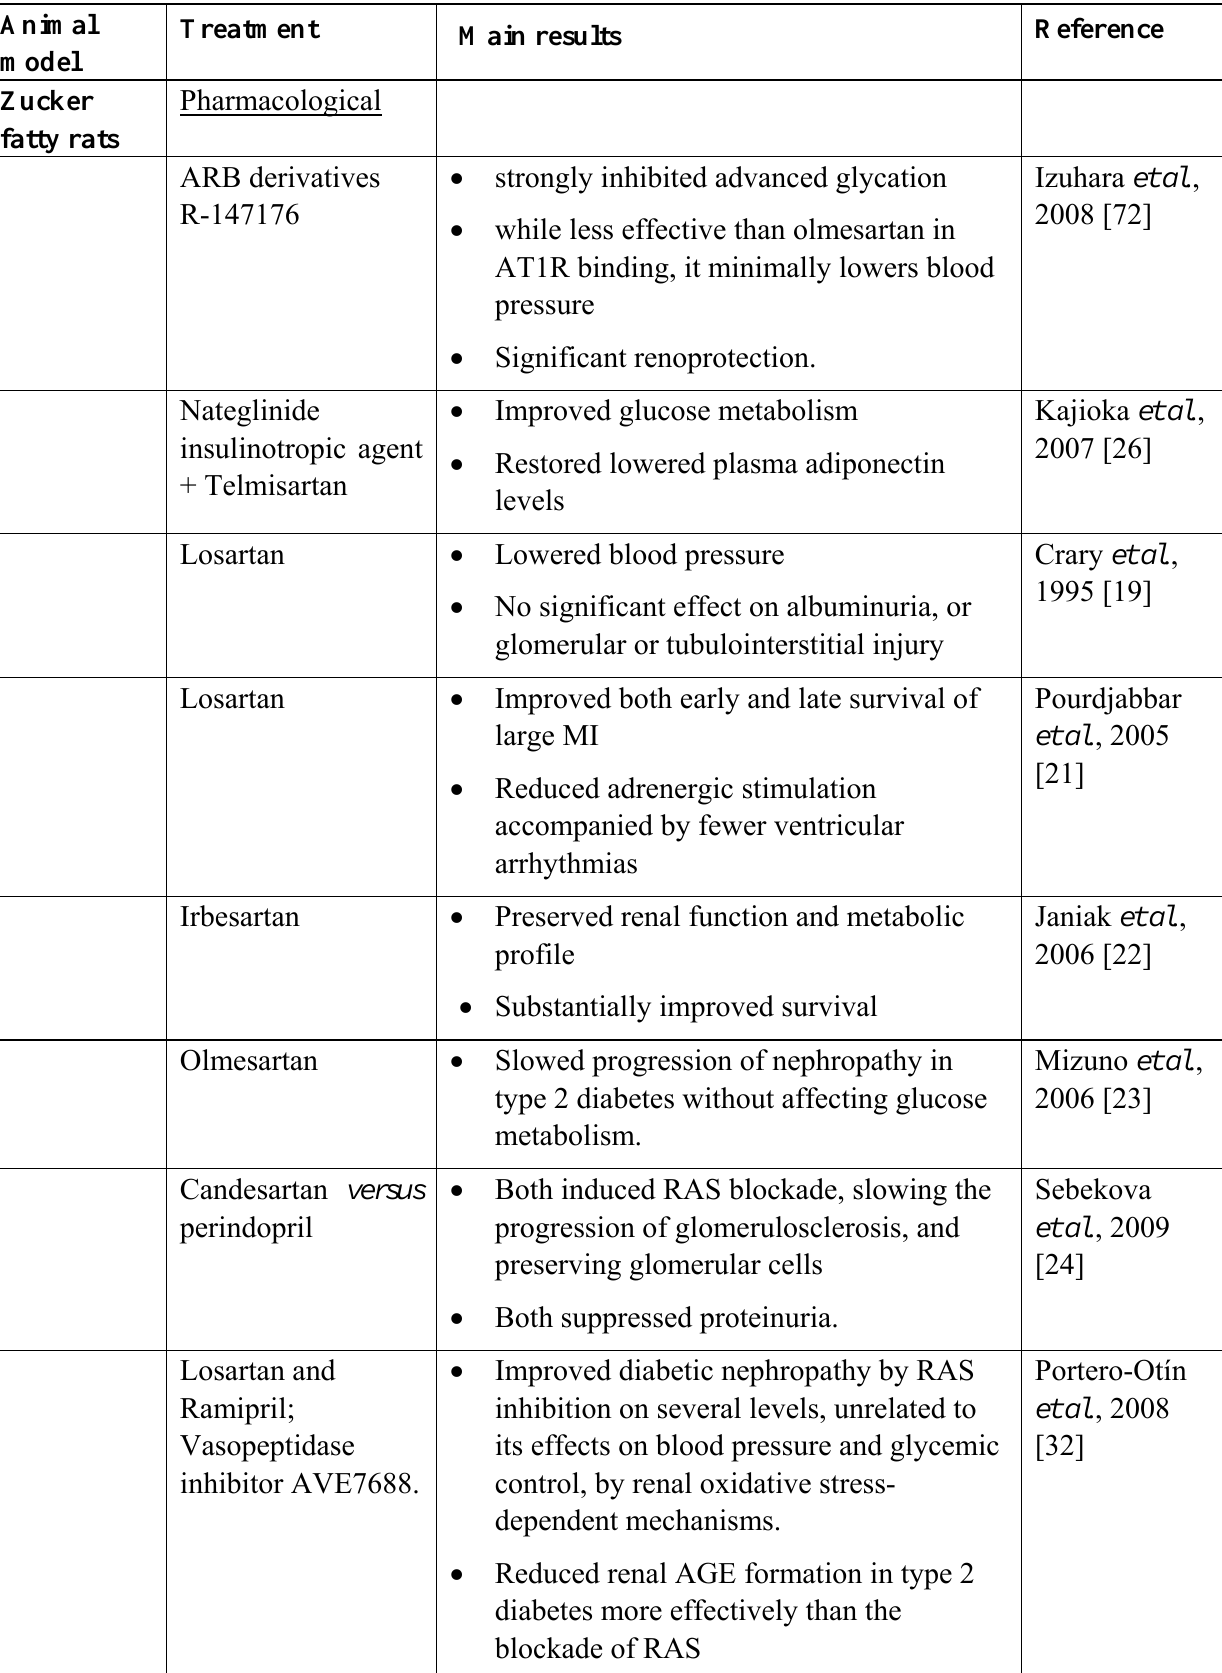
Table 1. Pharmacological and non-pharmacological treatments studied in hypertensive/diabetic animal models. Animal Treatment Main results Reference model Zucker fatty